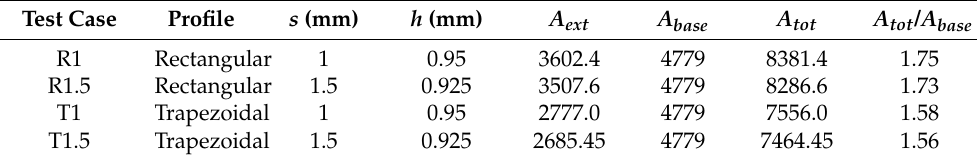
Figure 3. ( a ) Illustration and ( b ) example of actual image of straight fin samples employed in this study. Table 1. Finned surface dimensions.